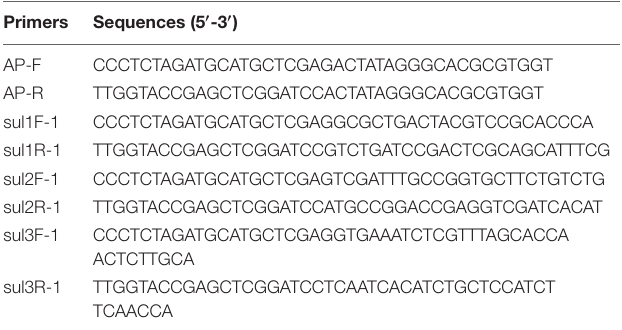
TABLE 4 | Primers for PCR amplification of flanking